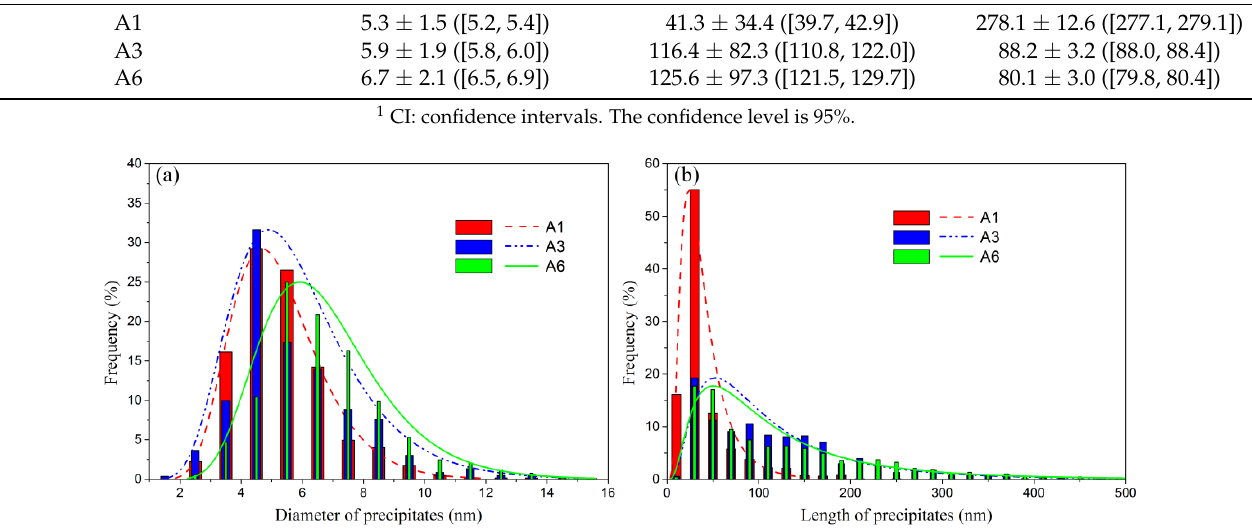
Figure 5. Transmission electron microscopy (TEM) images of the three investigated specimens: ( a ) A1, ( b ) A3 and ( c ) A6. Table 5. Average diameter, length and number density of the precipitates within the grains. Average Diameter of the Average Length of the Average Number Density Specimens Precipitates (CI 1 )/nm Precipitates (CI)/nm